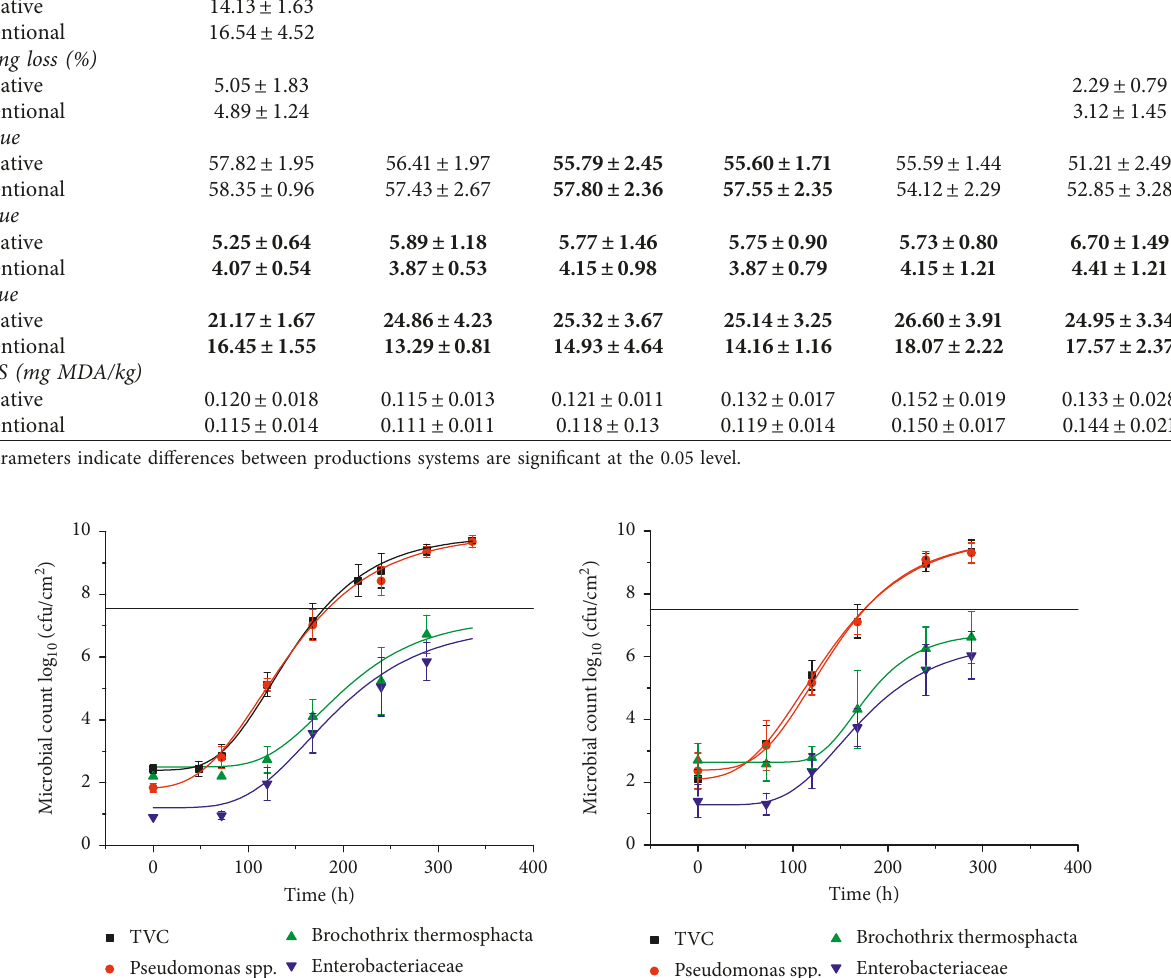
24 per investigation (cid:31)